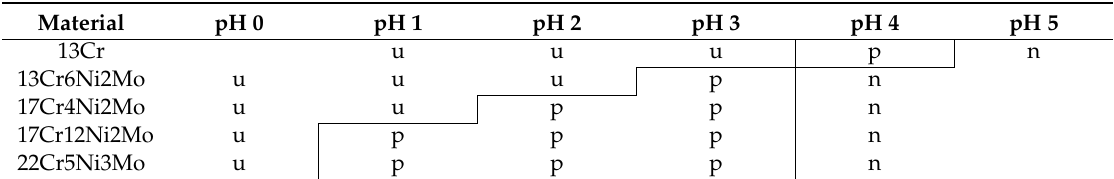
Table 3. Type of corrosive attack on investigated materials as function of pH in 30,000 ppm Cl – at 30 ◦